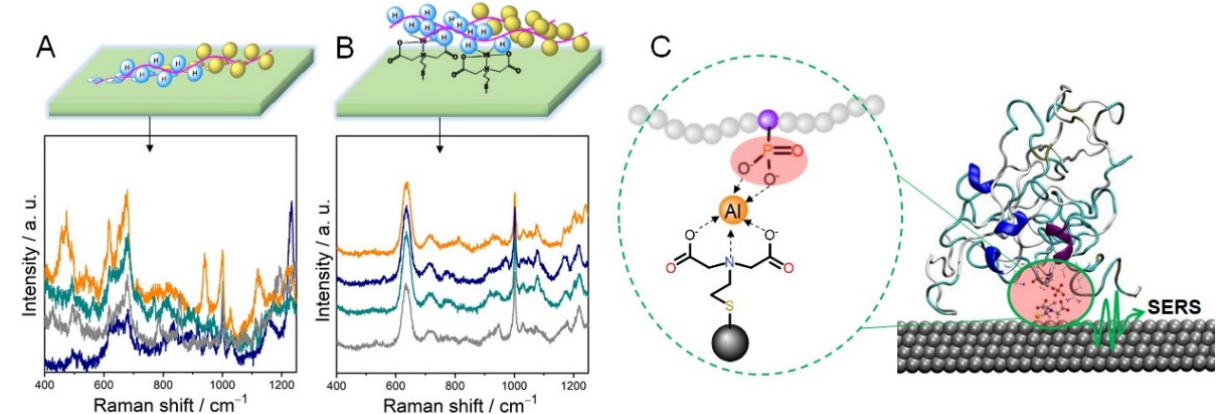
Figure 3. Iminodiacetic acid-modified Ag nanoparticles for His-tagged free ( A ), His-tagged ( B ), adapted with permission from [41]. Copyright [2019] American Chemical Society; ( C ) phosphorylated protein determination, adapted with permission from [42]. Copyright [2021] Elsevier.